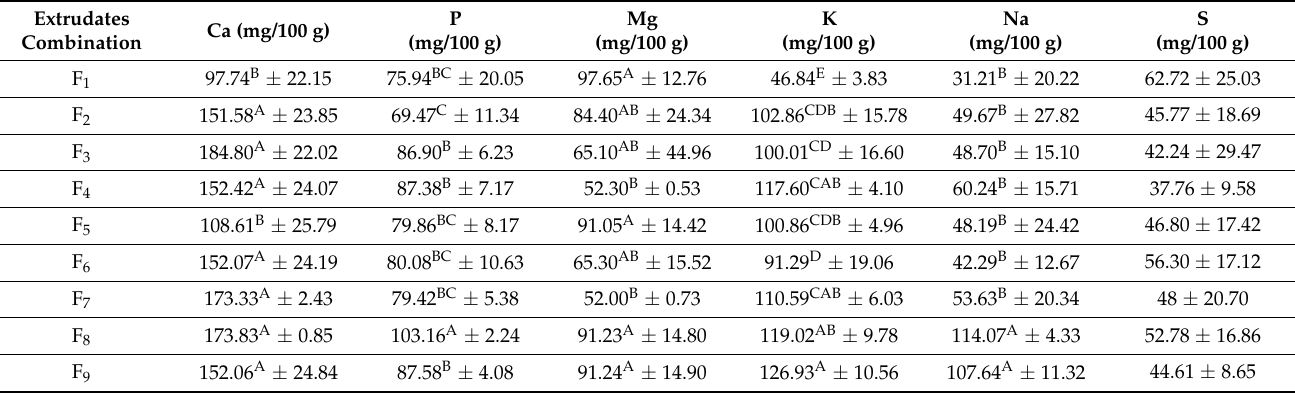
Table 11. Major mineral composition of neera honey incorporated